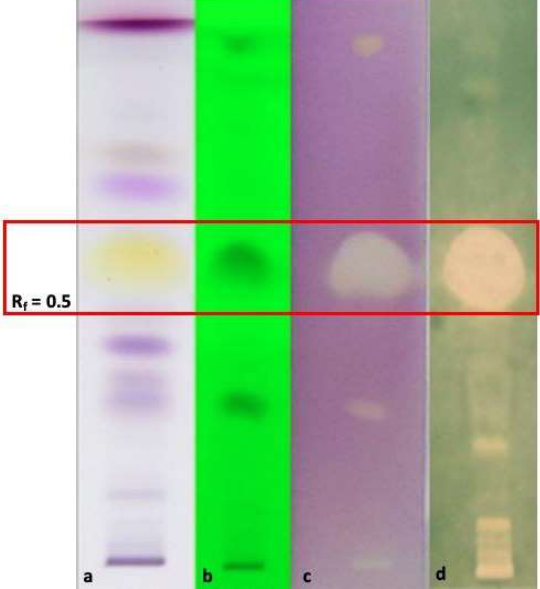
Figure 1. HP-TLC bioautographic assay to check the antioxidant capacity of O. campechianum EO against DPPH and ABTS radicals. ( a ): plate eluted and treated with vanillin sulphuric acid reagent; ( b ): plate eluted and visualised at λ = 254 nm wavelength; ( c ): plate eluted ad treated with DPPH; ( d ): plate eluted and treated with ABTS. The band at R f = 0.5 corresponds to eugenol, as verified eluting pure standard compound (data not shown) and comparing the result with related literature [29]. The large bleached bands at R f = 0.5 correspond to the capacity of eugenol to contrast the oxidative reactivity of the DPPH• (3) and ABTS•+ (4) radicals.